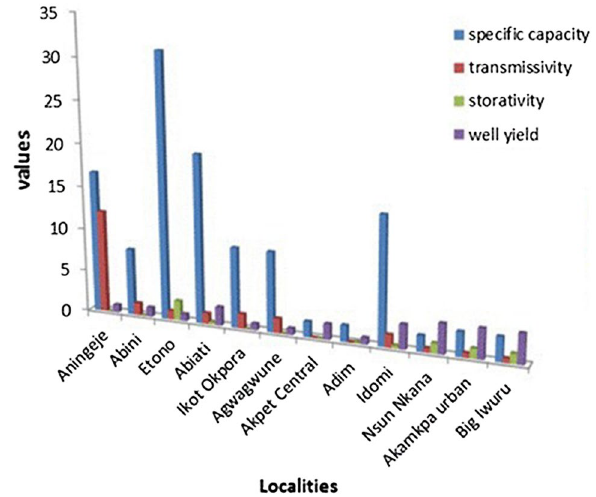
Fig. 7 Distribution of aquifer parameters in the study